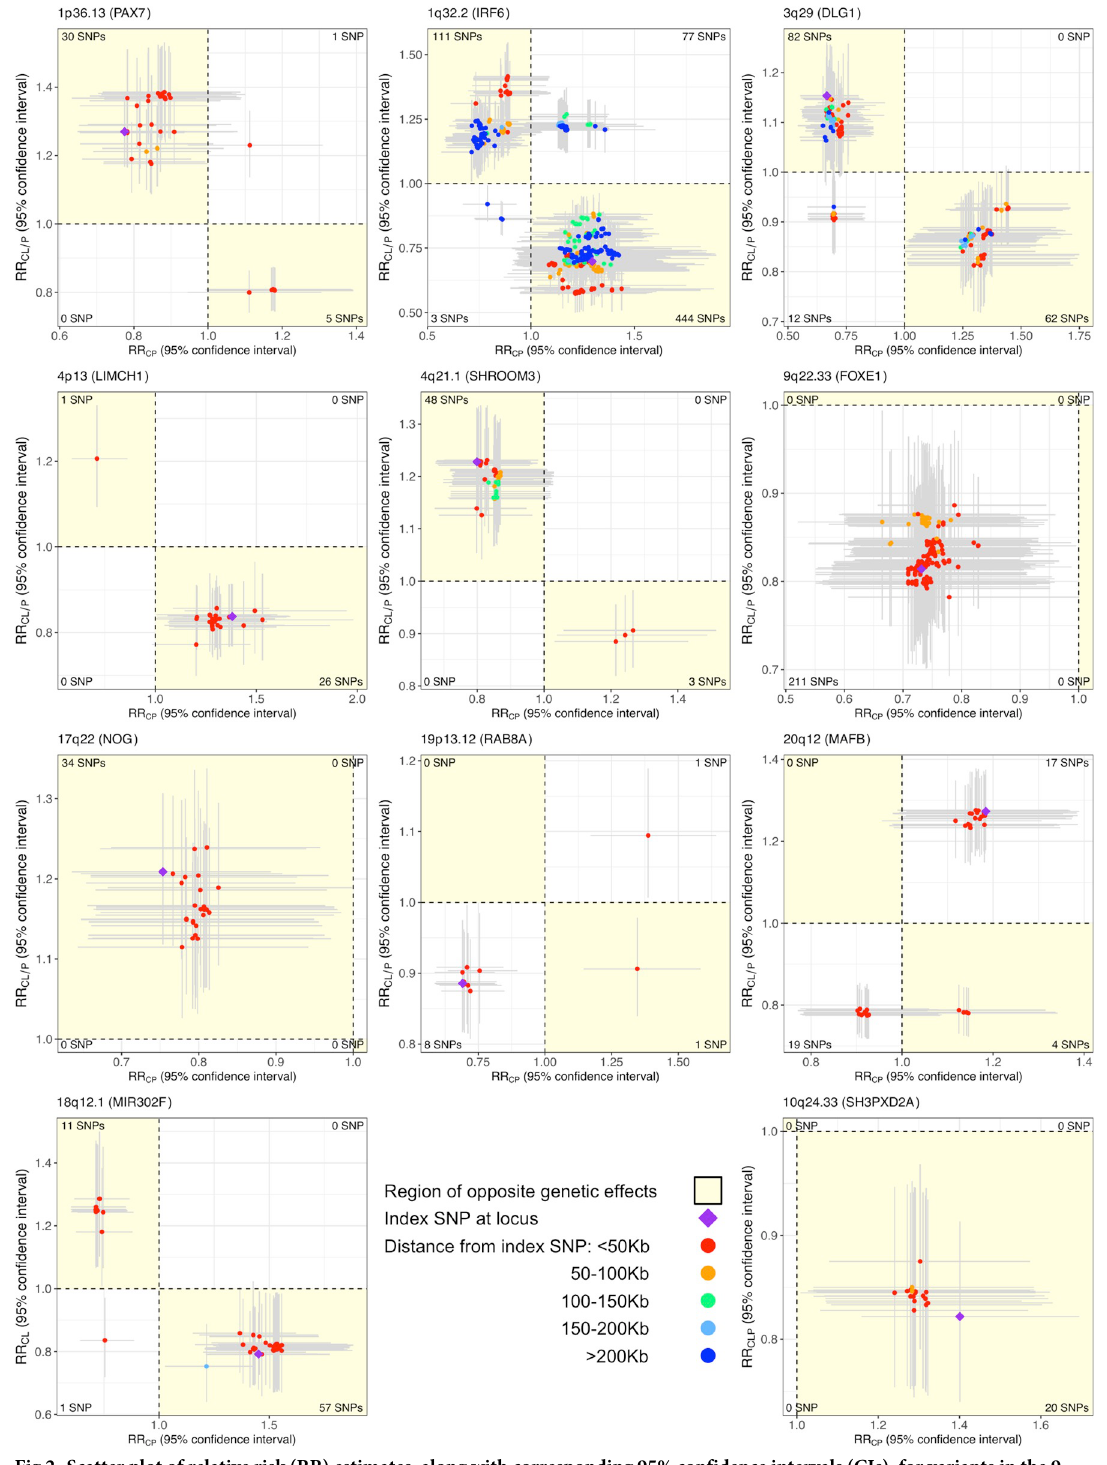
Fig 2. Scatter plot of relative risk (RR) estimates, along with corresponding 95% confidence intervals (CIs), for variants in the 9 loci showing statistical evidence of genetic overlap between CL/P & CP, along with 2 additional loci of genetic overlap between component OFC subtypes. RR estimates are color annotated based on distance of SNPs from the index/lead SNP. LD-based color annotation is not used since these RR estimates are from multi-ethnic analyses and consequently, there is no unique LD between SNPs. Horizontal (vertical) error bar around each RR estimate corresponds to the 95% CI for the OFC subgroup represented on the